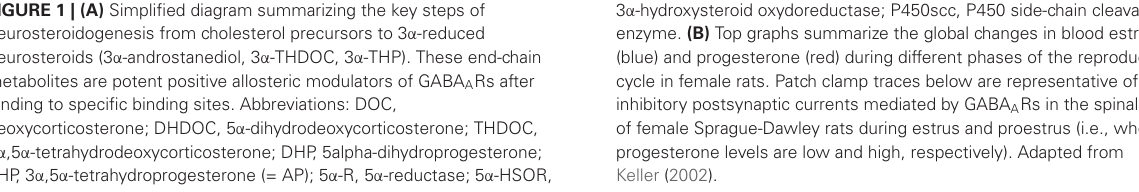
FIGURE 1 | (A) Simplified diagram summarizing the key steps of neurosteroidogenesis from cholesterol precursors to 3 α -reduced neurosteroids (3 α -androstanediol, 3 α -THDOC, 3 α -THP). These end-chain metabolites are potent positive allosteric modulators of GABA A Rs after binding to specific binding sites. Abbreviations: DOC, deoxycorticosterone; DHDOC, 5 α -dihydrodeoxycorticosterone; THDOC, 3 α ,5 α -tetrahydrodeoxycorticosterone; DHP, 5alpha-dihydroprogesterone; THP, 3 α ,5 α -tetrahydroprogesterone (= AP); 5 α -R, 5 α -reductase; 5 α -HSOR,